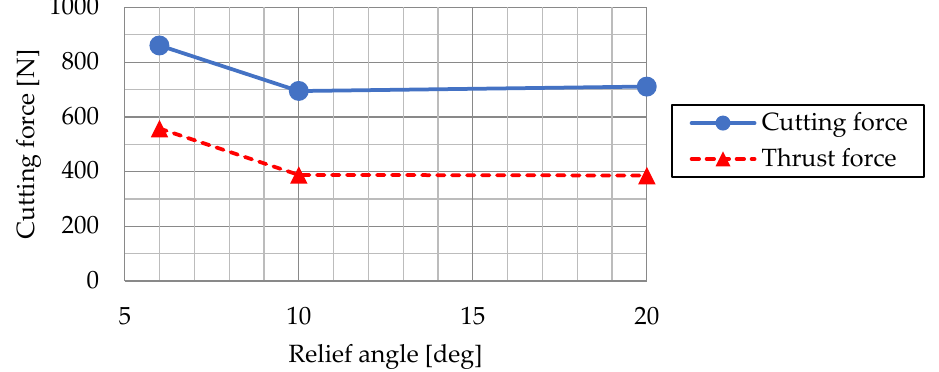
Figure 9. Cutting force with relief angle change in orthogonal cutting (v = 20 m/min, f = 0.05 mm/rev, t = 2 mm).